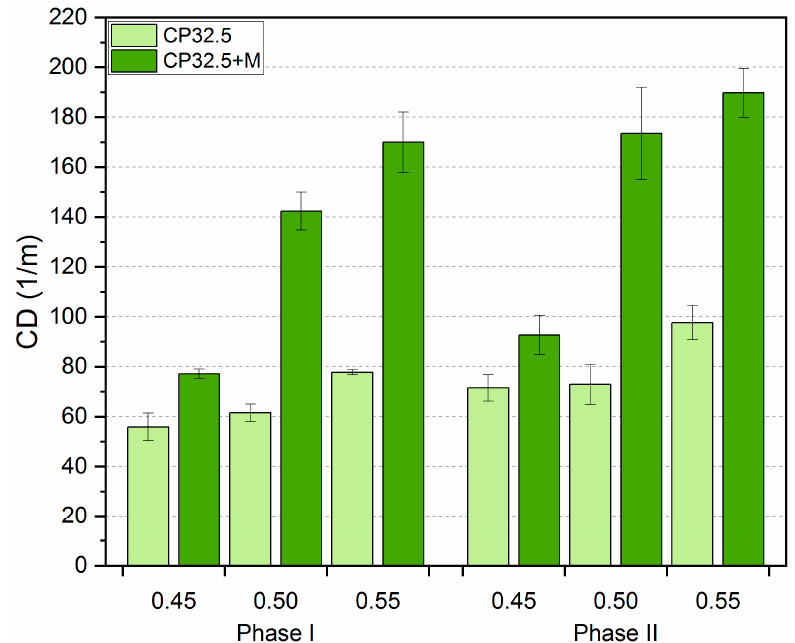
Figure 6. Results of the crack density ( CD ) of the lime cement matrix after the first and second phase of thermal load; error bars show standard deviation.